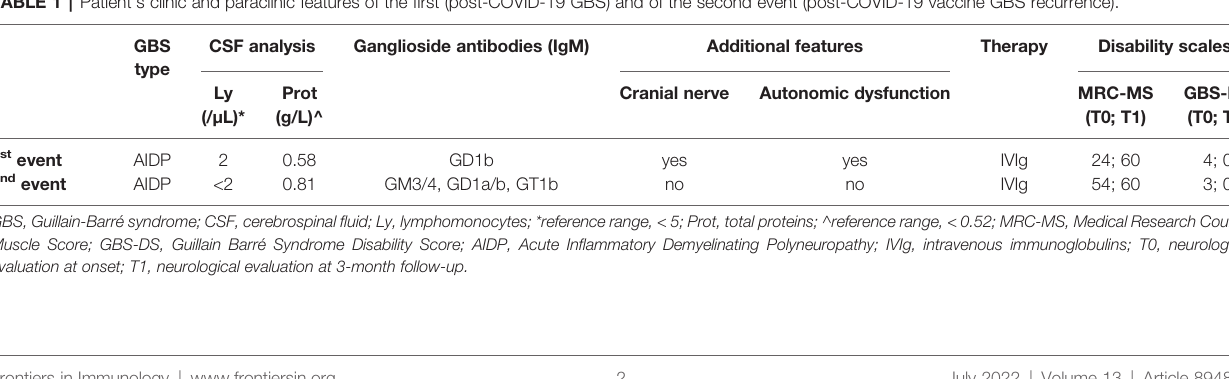
TABLE 1 | Patient ’ s clinic and paraclinic features of the fi rst (post-COVID-19 GBS) and of the second event (post-COVID-19 vaccine GBS